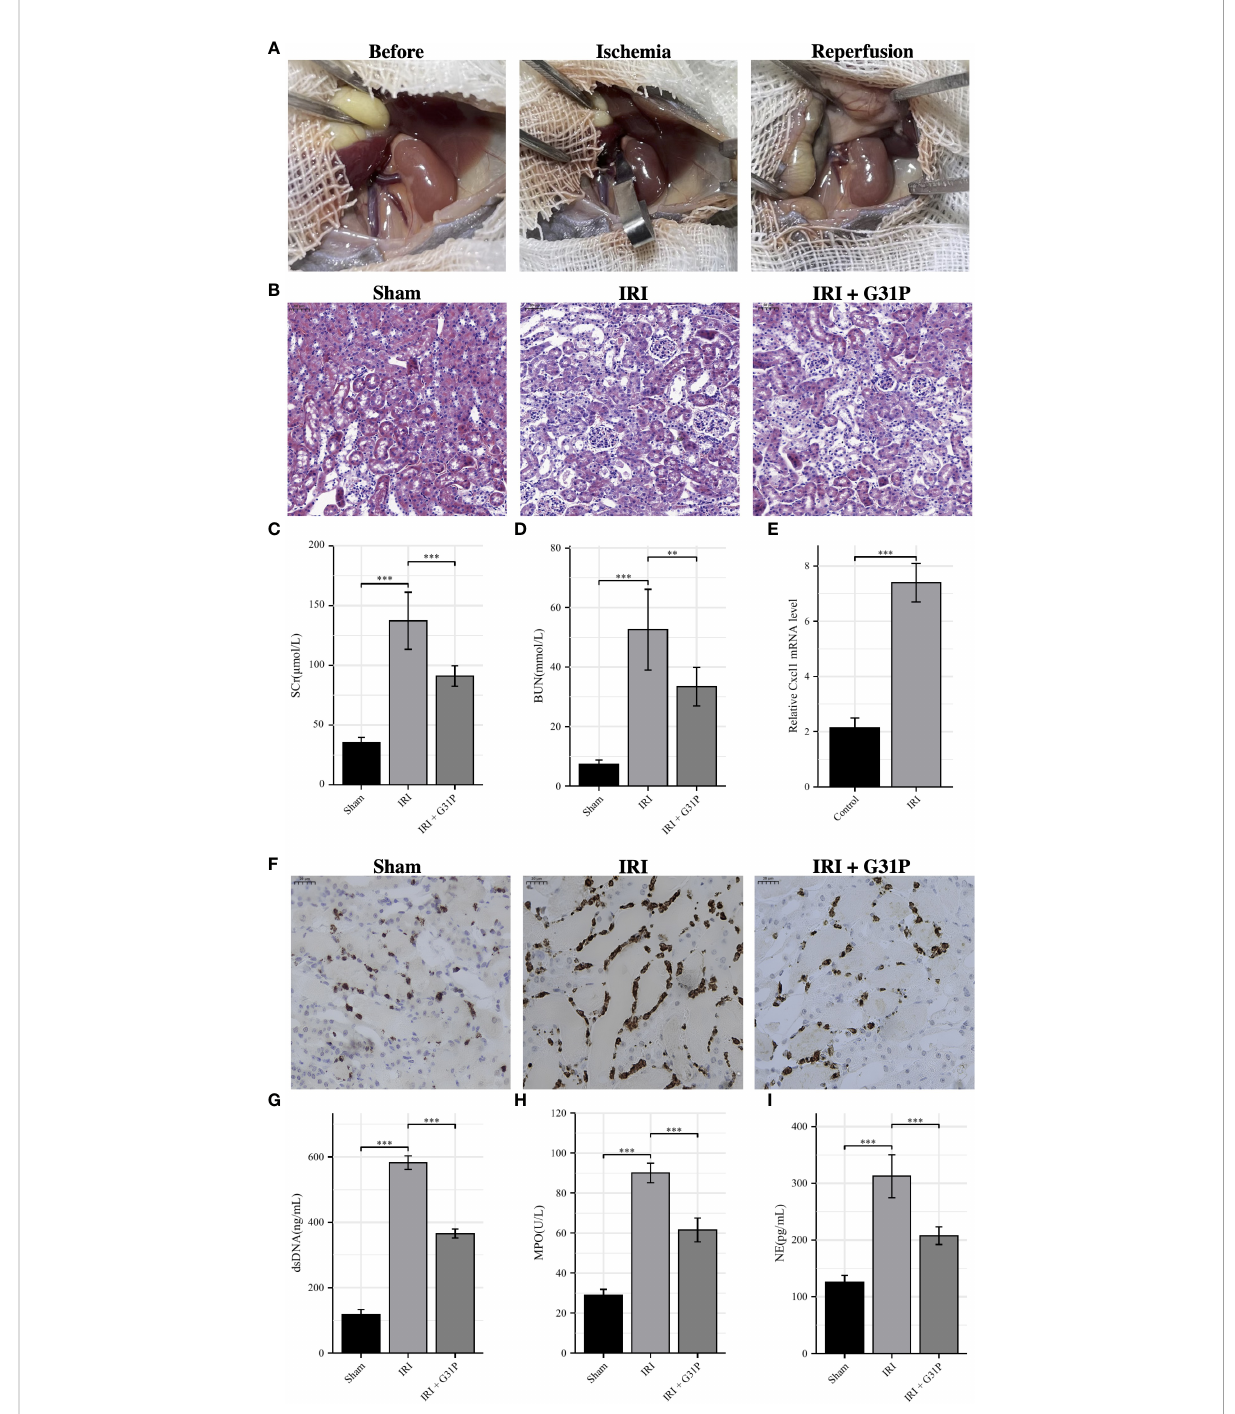
FIGURE 8 Experimental veri fi cation processes. (A) : The surgical process of renal ischemia-reperfusion in mouse. (B) : H&E staining of the renal tissues from Sham mice, IRI mice and IRI+ G31P mice. (C, D) : Serum creatinine and BUN were measured in the Sham group, the IRI group and the IRI+G31P group. (E) : mRNA expression of Cxcl1 in kidney tissue of the control group and the IRI group. (F) : Immunohistochemistry staining of NE in Sham mice, IRI mice and IRI+ G31P mice. (G – I) : NET-related markers (dsDNA, MPO, NE) in the serum of the Sham group, the IRI group and the IRI +G31P group. H&E, hematoxylin and eosin; IRI, ischemia reperfusion injury; NE, neutrophil elastase; MPO, myeloperoxidase. **P < 0.01, ***P <